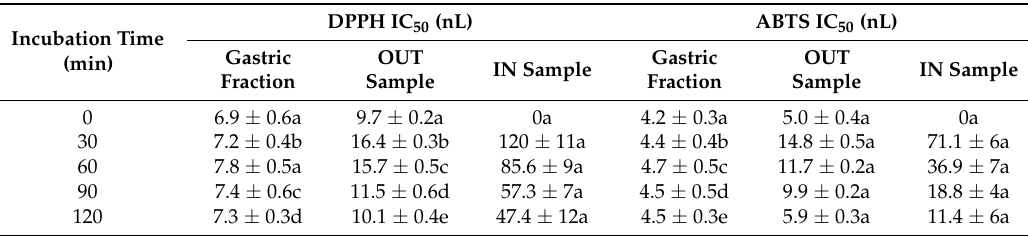
Table 3. Changes in antioxidant activity of A. mearnsii bark extract determined by DPPH and ABTS assays at different time points during in vitro gastrointestinal digestion.